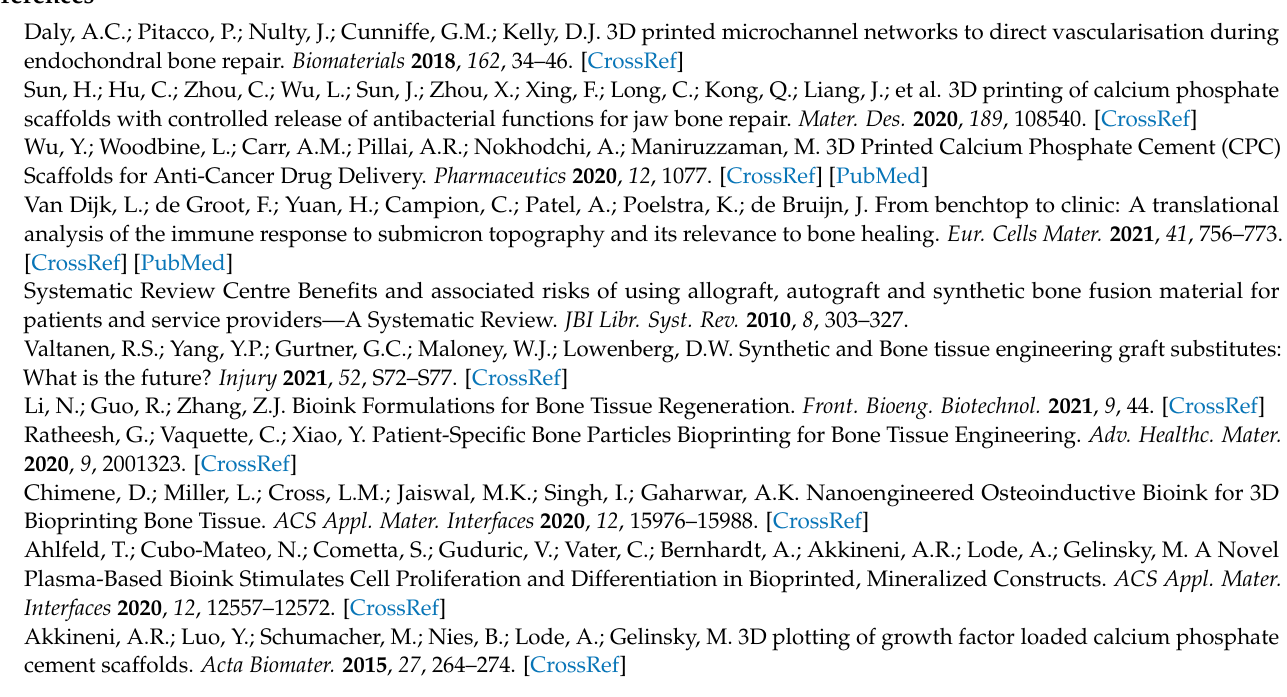
4 ºC. Figure S3: Flow curves. Figure S4: Amplitude sweeps for stiffness determination of samples non-crosslinked (A) and after 2 min (B) or 5 min (C). Figure S5: Printed disk simple placed between rheometer plates for stiffness test. Figure S6: Fresh printed cubes. Figure S7: Swelling behavior of fresh printed cubes. Higher particle release for 150–250 µ m inks (30BCP2 and 15BCP2) can be seen from min 60. Figure S8: Visual appearance of dehydrated cubes. Shrinkage is notably higher in 15BCP1 and 15BCP2 samples due to its larger water content in both formulas with regard to 30BCP2. Table S1: Line width at different printing speeds tested. Table S2: Weight and height of dehydrated 3D-printed cubes. Video S1: Extrusion width calibration, Video S2: Disk printing